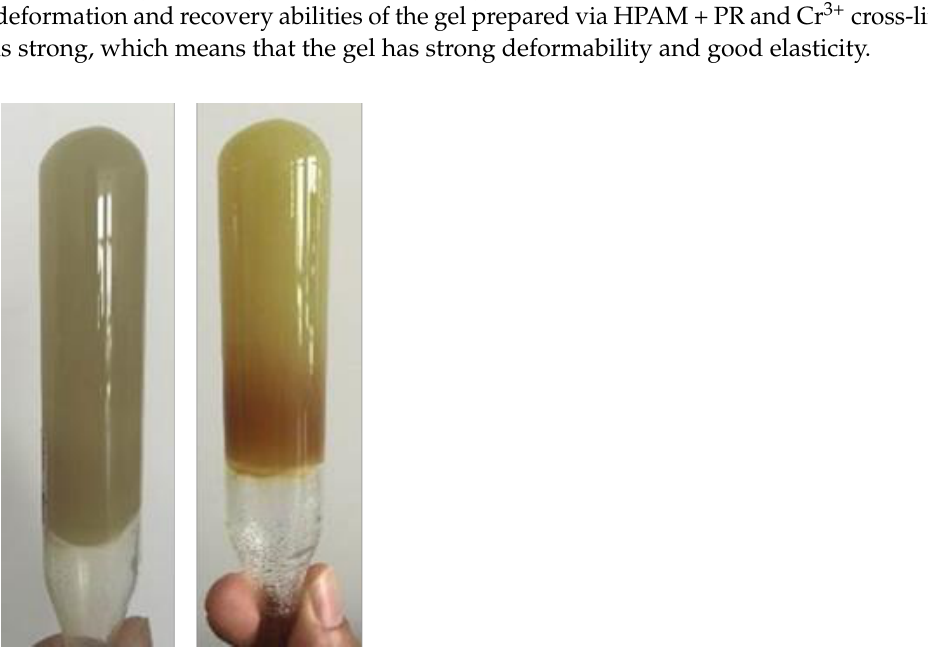
Figure 8. The gelation performance of gel prepared via PR and Cr 3+ cross-linker after aging 3 d and 30 d, respectively. Table 5. Plugging capacity of the gel system.